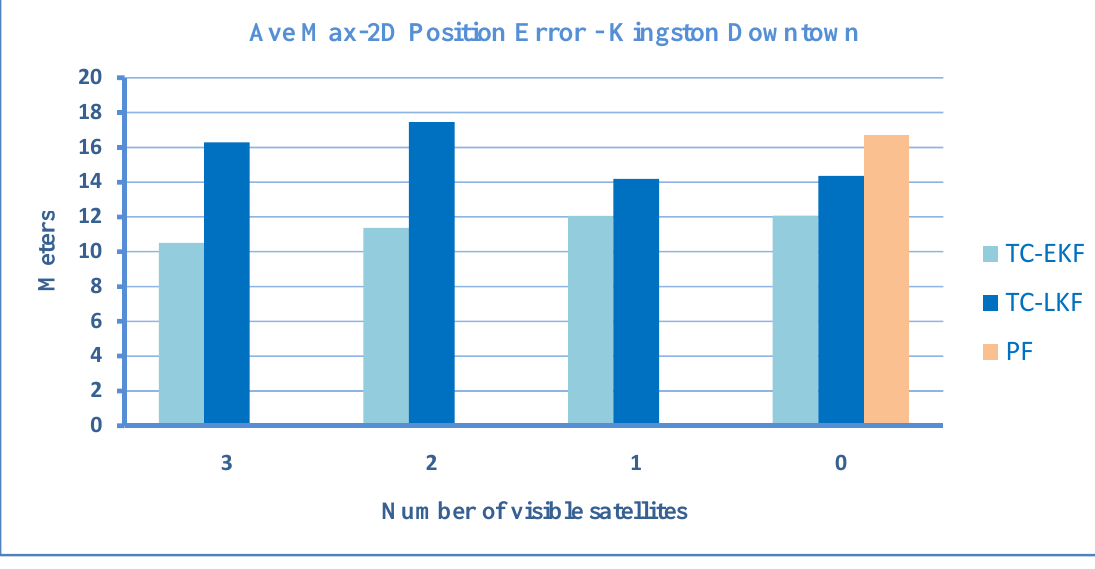
Figure 8. A comparison of tightly-coupled (TC-EKF), TC-linearized KF (LKF) and particle filter (PF) for the average maximum 2D position error for the Kingston downtown